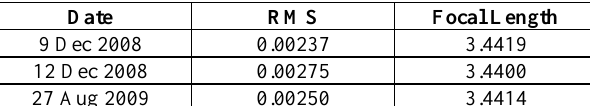
Table 1: RMS and focal length values of the parabola fit for the different setup